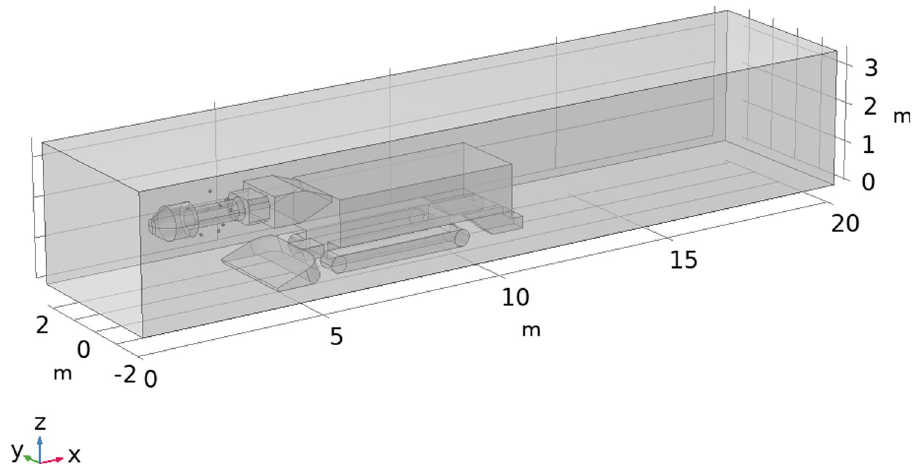
Fig 7. Field application model diagram of the spraying device.